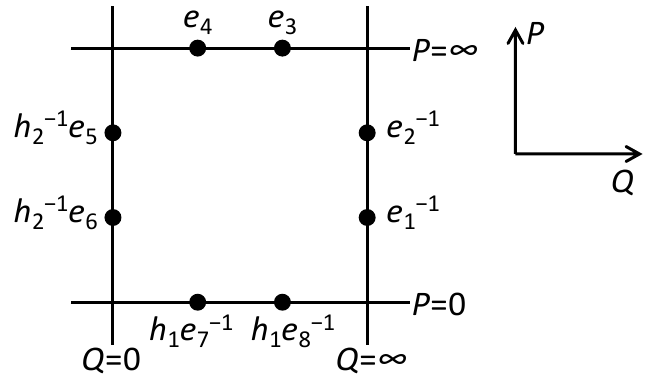
Figure 4 . Asymptotic values of the D 5 curve (2.30). After applying the normal ordering, the asymptotic values are f e (cid:0) 1 signs in displaying the asymptotic values for